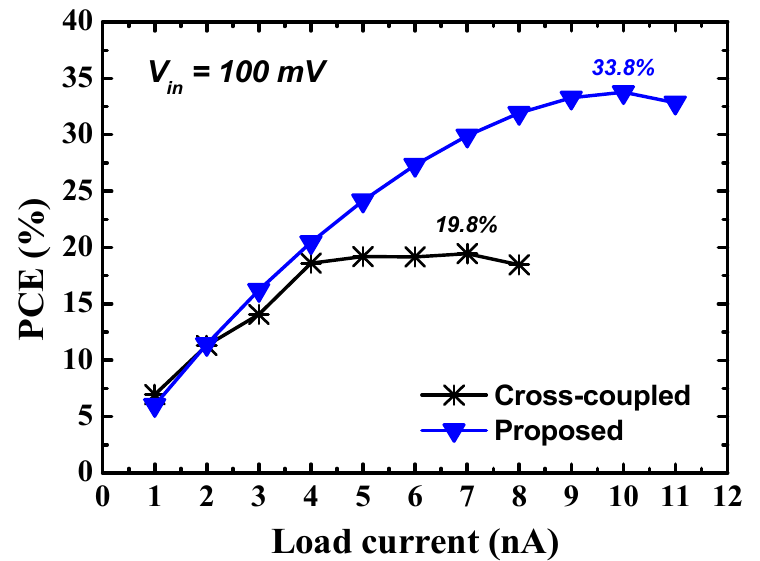
Figure 8. Simulated PCE according to the load current of the cross-coupled charge pump and the proposed charge pump.